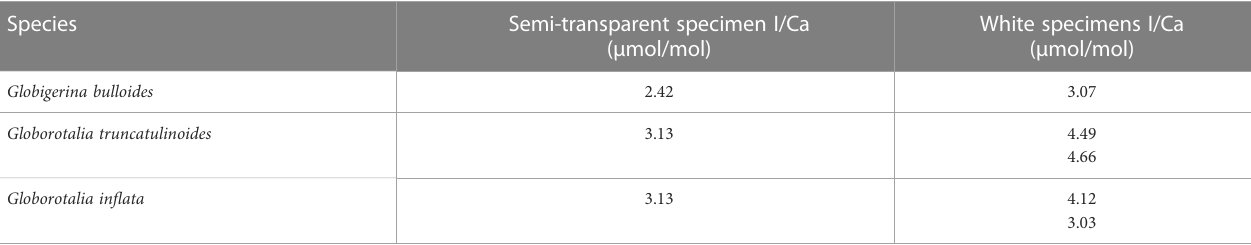
TABLE 3 I/Ca results of foraminifera with semi-transparent and cloudy appearances from ODP core 1088 (0 to 1 cm).